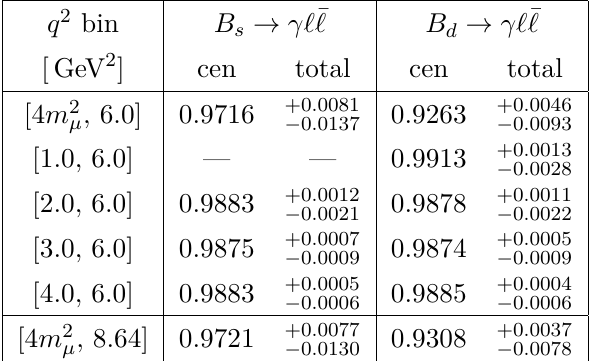
Table 4 . The q 2 -integrated lepton-flavour universality ratios R qγ for B s → γ‘ ¯ ‘ [left] and B d → γ‘ ¯ ‘ [right] in several q 2 bins for the approximation“NLP all”. The total uncertainty is obtained as for table